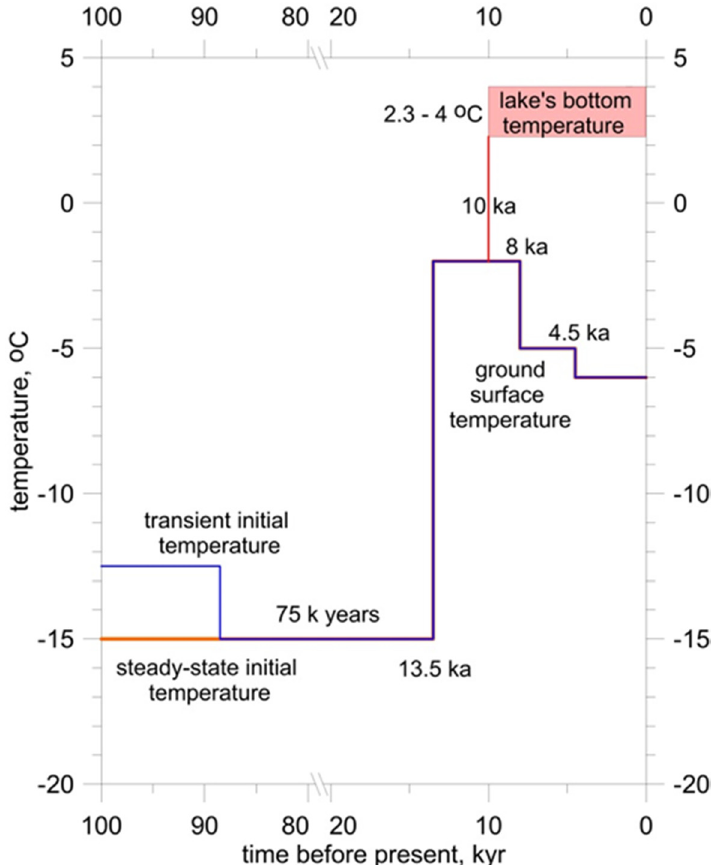
Figure 6. “Temperature history”. The time–varying ground surface temperature used as a boundary condition in the simulations that start by jump from − 15 °C to − 2 °C at time 13.5 ka, followed outside a lake by cooling to − 5 °C and − 6 °C at times 8 ka and 4.5 ka, respectively. At the time of a lake origin, 10 ka, the ground temperature at the site of a lake warms up from − 2 °C to +2.3 °C (or to +3 °C or +4 °). The steady-state initial T – z profile at time 13.5 ka corresponds to the surface temperature of − 15 °C, the transient initial T – z profile to the temperature history shown by the “transient initial temperature” curve (see text in Section